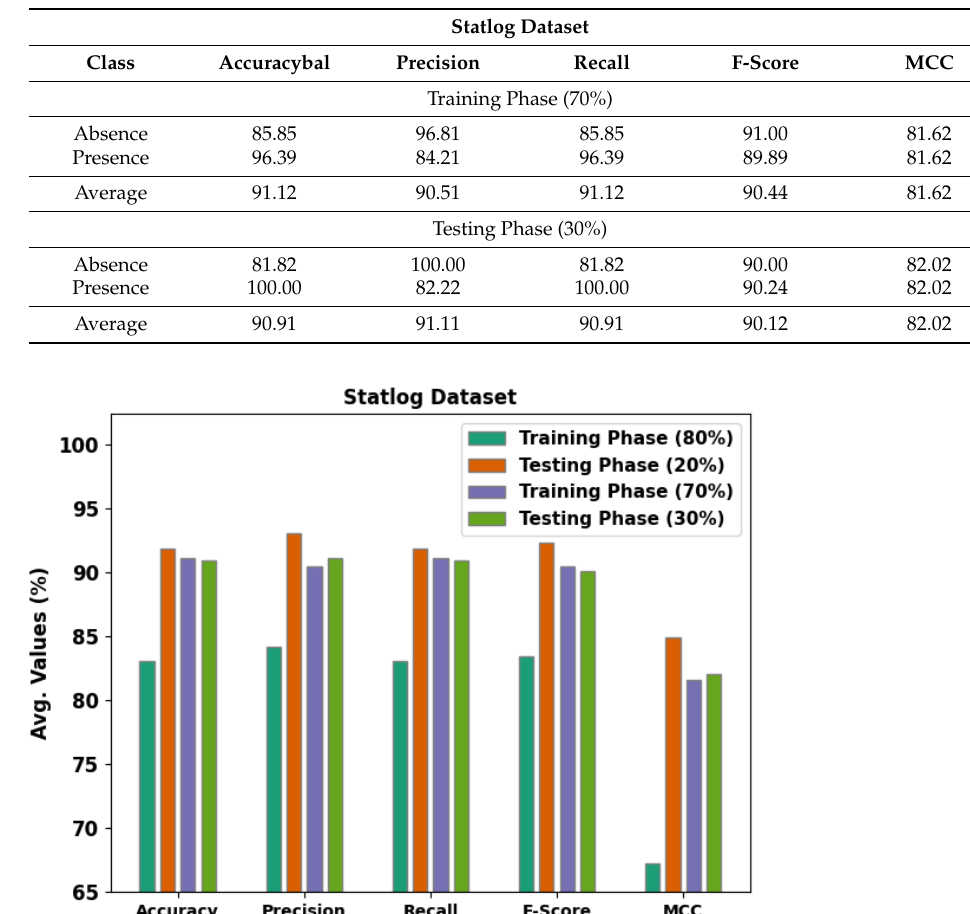
Figure 9. Average analysis results of the MLMDMC-ED algorithm upon Statlog dataset.